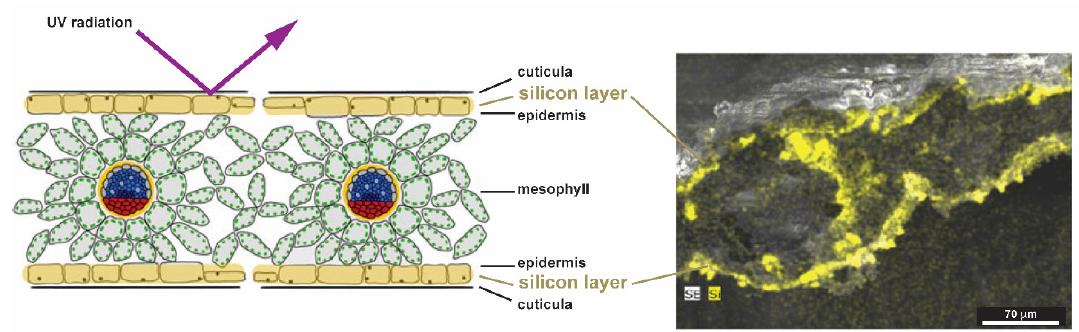
Figure 17. Scheme of a leaf cross section and distribution of silica (colored as yellow) in the leaf cross-section of a dried leaf of Phragmites australis (a type of common reed) revealed by SEM equipped with an element detector EDR. Reproduced from [119] with permission from Springer Nature.